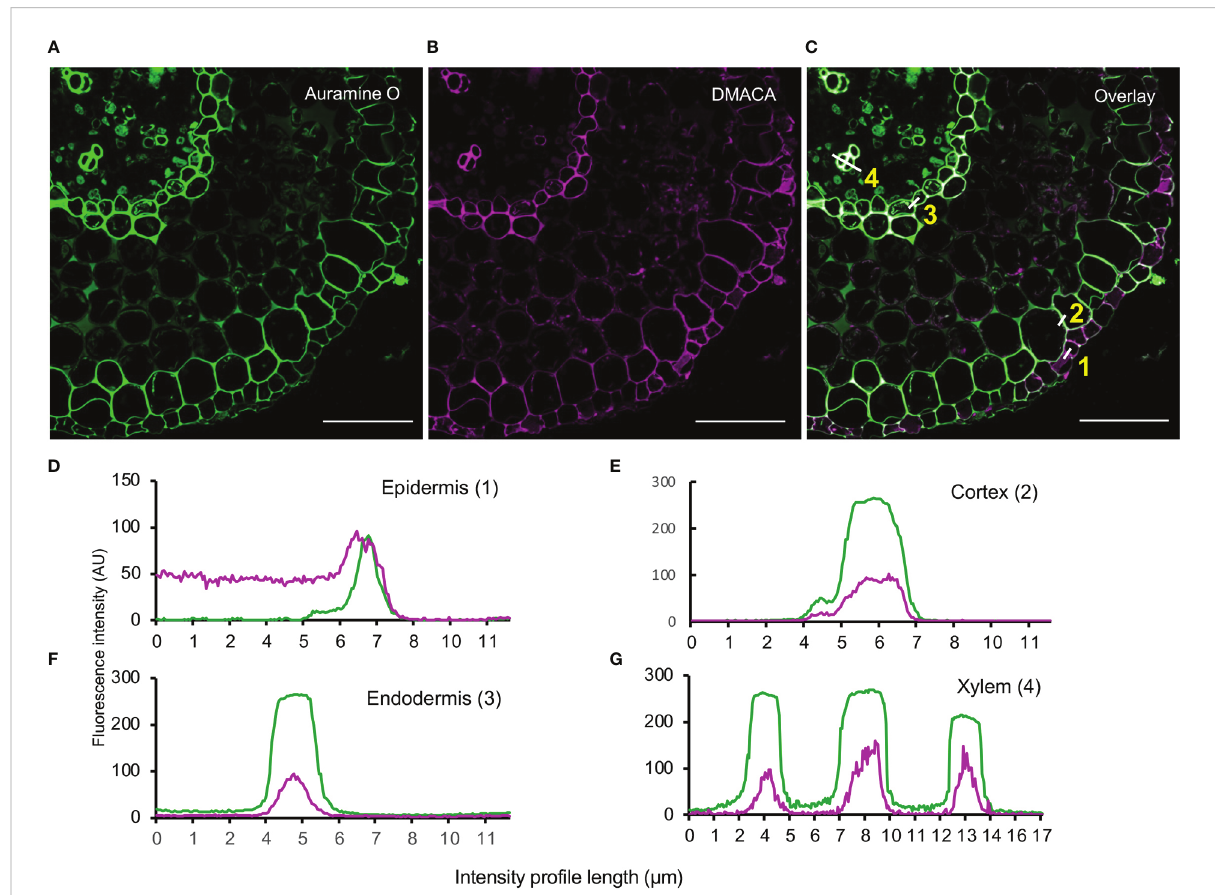
FIGURE 6 Double staining with (A) Auramine O (green) and (B) DMACA (magenta) on cross-sections (taken at 500 µm from the root tip) of 28-day-old Populus tremula x Populus tremuloides roots. (C) Overlay showing in situ localization of ligni fi ed (xylem) and suberized areas (endodermis and cortex) together with PAs in lateral root cross-sections. Scale bars = 50 µm. (D – G) Fluorescence intensity pro fi les across cell walls in four cell layers (white lines in (C) ) showing overlapping fl uorescence of Auramine O (green) and DMACA (magenta) in epidermis, cortex, endodermis and xylem cell walls. The experiment was performed on 3-4 roots originating from separate plants yielding similar results in